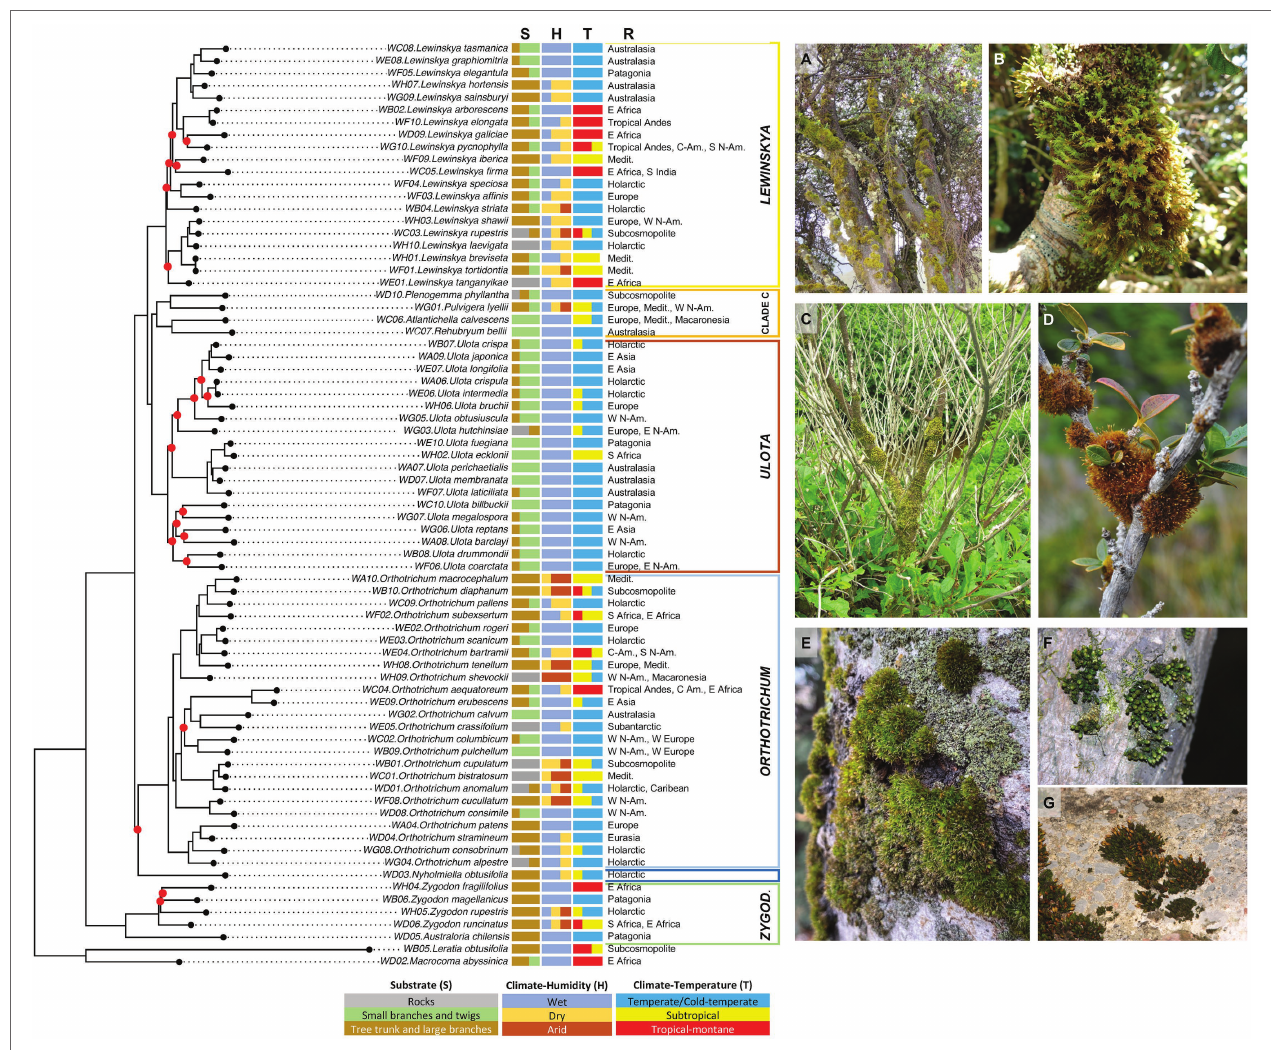
FIGURE 2 | Ecological and biogeographical affinities of the species in the phylogenetic framework (IQ-TREE analysis). For each species, the following information is shown sorted by columns: S—substrate preferences; H—Climate-Humidity, i.e., degree of humidity of the climatic environment in which the species usually grows; T—Climate-Temperature, i.e., degree of climatic thermicity according to the latitudinal climatic bands where the species thrive; R—geographical range. See Materials and Methods section for details on the environmental categories analyzed. Representative pictures: (A) Lewinskya spp. dominating communities on tree trunks from Bale Mts., Ethiopia; ( B) L. graphiomitria on small branches from Mt. Egmont, North Is., New Zealand; (C) Plenogemma phyllantha on a shrub trunk and branches from coastal Olympic Peninsula, Washington, United States; and (D) Ulota fuegiana on shrub twigs from Beagle Channel, Patagonia, Chile. (E) Orthotrichum diaphanum dominating communities on tree trunk from Madrid, central Spain; (F) O. consobrinum on a tree trunk from Nara, Honshu Is., Japan; and (G) O. anomalum on a rock from Burgos, Spain. Abbreviatures: Medit.—Mediterranean Basin, N-Am.—North America; and C-Am.—Central